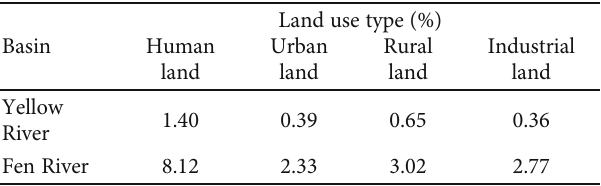
Figure 5: Spatial distribution of human land use (a), NH Table 4: Comparison of the human land use in Yellow River and Fen River